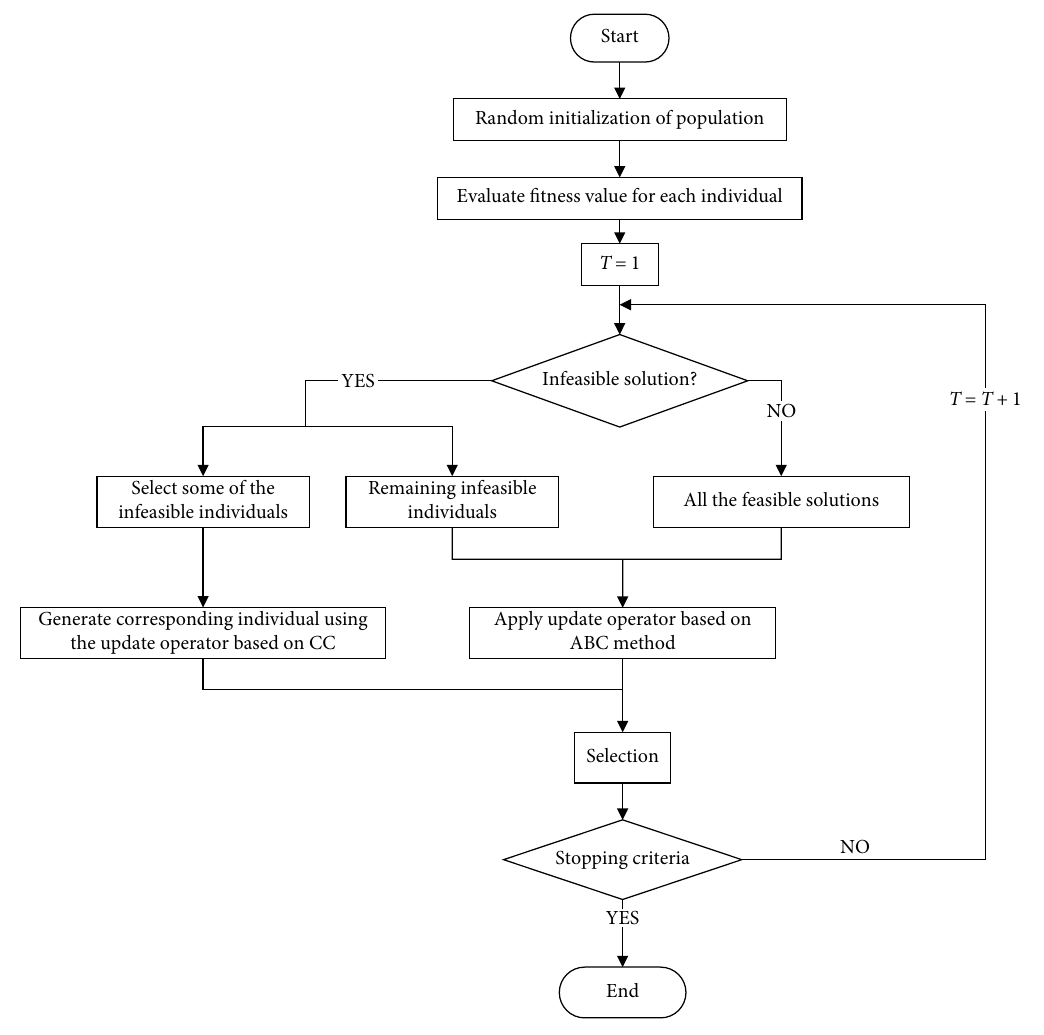
Figure 1: Overall flow chart of the proposed algorithm.